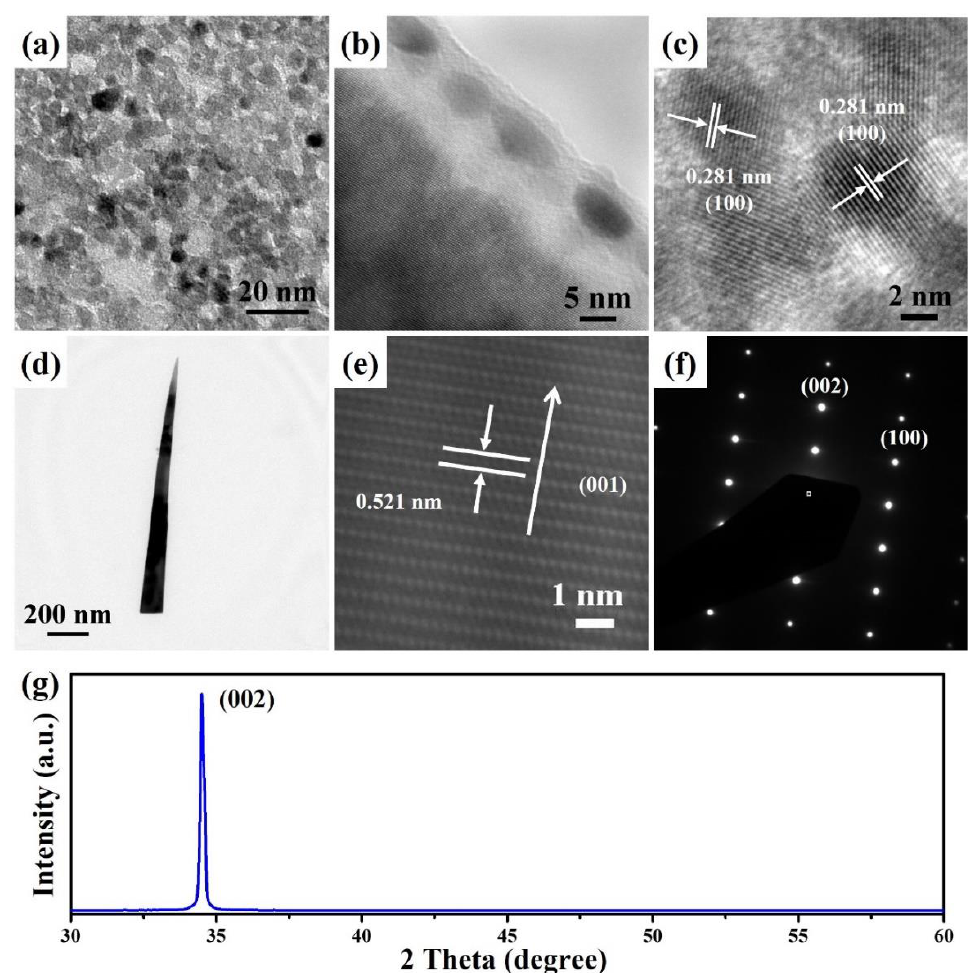
Figure 6. The ( a ) top-view TEM, ( b ) cross-sectional TEM, and ( c ) HRTEM images of a ZnO seed layer were fabricated on the silicon substrate. The ( d ) TEM, ( e ) HRTEM, and ( f ) SAED pattern images of a ZnO nanoneedle (MW1-3). ( g ) XRD spectrum of ZnO nanoneedle arrays was fabricated on the silicon substrate with the ZnO seed layer (MW1-3).